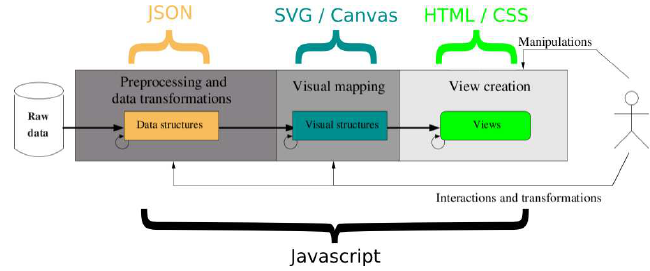
Fig. 1. Adapted reference model for this work based on [21] The pipeline starts with the raw data, extracted from databases or sensors, for example. Pre-processing turns raw data into a normalized, JSON [22] structure. This first step is out of scope of OPENEDEYES, it expects as input a well formatted JSON structure. These JSON data tables can be static (stored in a file system) or dynamically returned by a data server that provides a webservice. An advantage of this approach is that the same data can be used by different web applications. Data will be graphically represented as visual structures, by a process called visual mapping. Visual structures in OPENEDEYES are SVG elements (vectors), or a Canvas bitmap (HTML 5 element) [23]. Finally the views are created, which are HTML documents [23] formatted using CSS sheets [24]. The transition between each stage of this pipeline is done by pure JavaScript, as well as the user interactions after the view creation. These interactions may or may not perform new requests to the